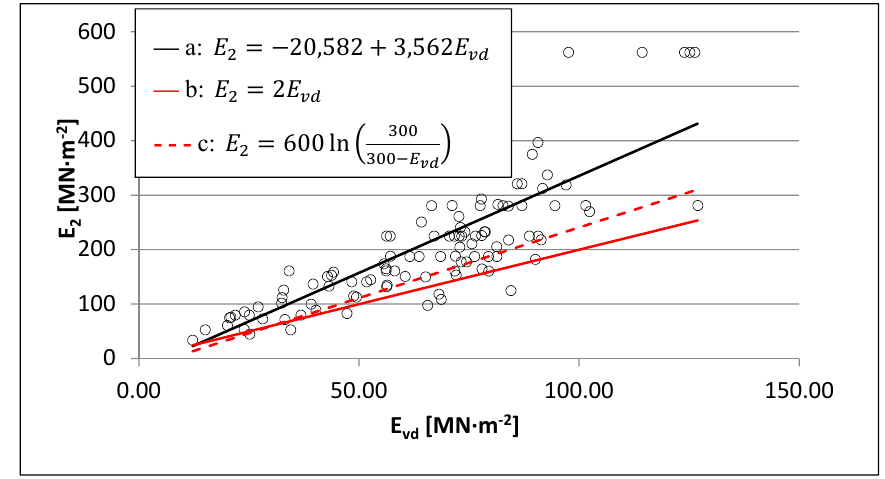
Figure 9. Estimation of the static constrained modulus during secondary compression (E 2 ) based on values of dynamic constrained modulus (E vd ) according to: (a) the original model of linear regression (proposed in [83]); (b) simplified conversion of E vd into E 2 occasionally applied in practice; (c) the formula admissible in case of no data on other dependencies between E vd and E 2 [88], in view of measurements of load-bearing capacity taken using a static plate on 109 di ff erent types of fire road surfaces [83].